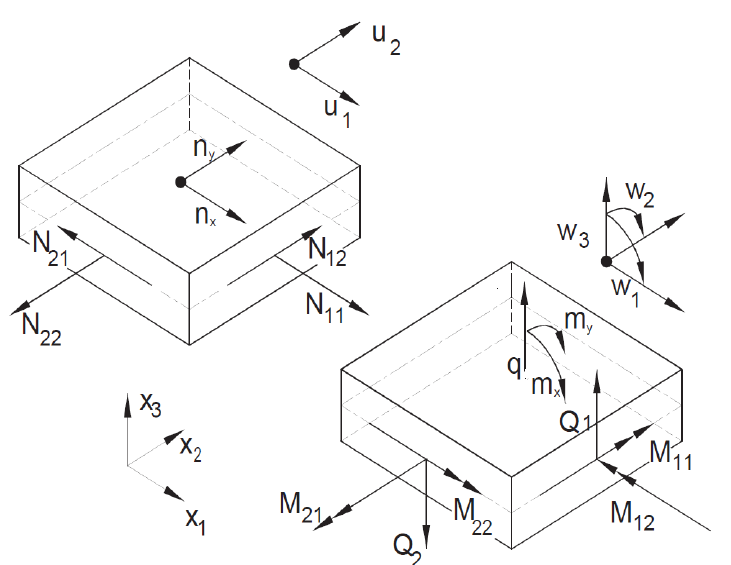
Figure 2. Sign convections for the displacements, rotations, tractions, and moments. The in-plane displacements of the plate are given in Equation (1):